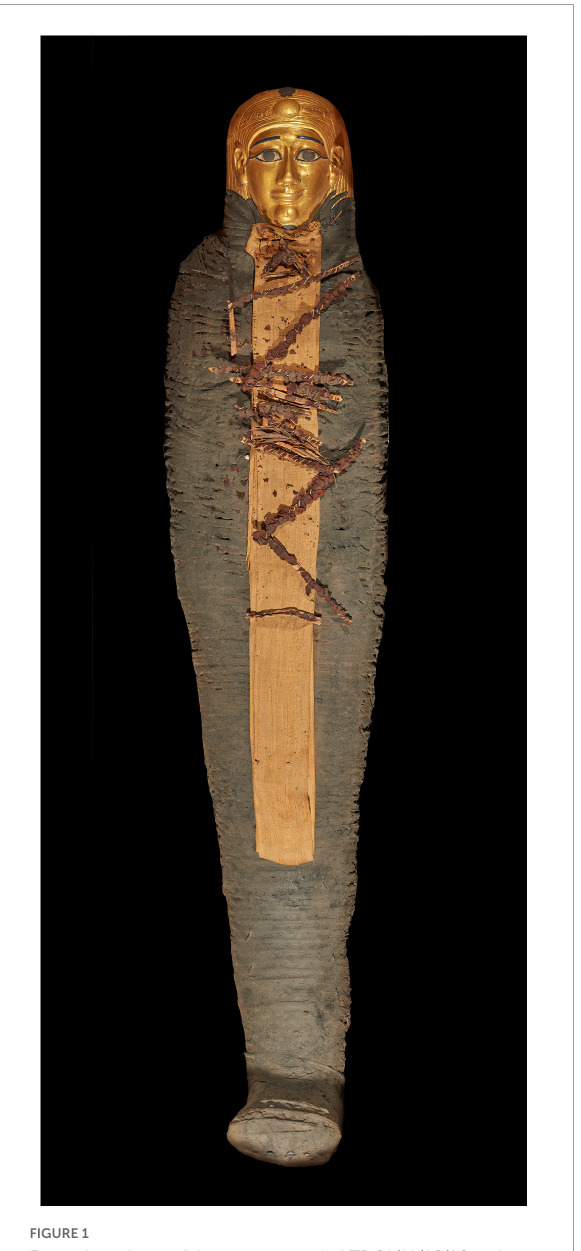
FIGURE1 Front view photo of the mummy coded TR 21/11/16/16 at the Cairo Egyptian Museum. The mummy wears a gilded head mask, and the body is fully covered by brown-colored wrapping. Dried ferns are placed on a light beige rectangular linen on the front surface of the body.